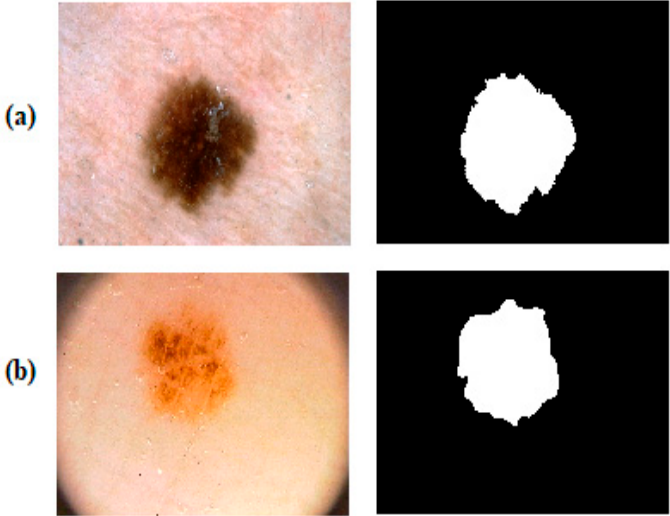
Figure 2. Dermoscopic skin lesion images and their ground truths from datasets. ( a ) a dermoscopic image sample and its binary ground truth from the ISBI 2017 dataset, ( b ) a dermoscopic image sample and its binary ground truth from the PH2 dataset.